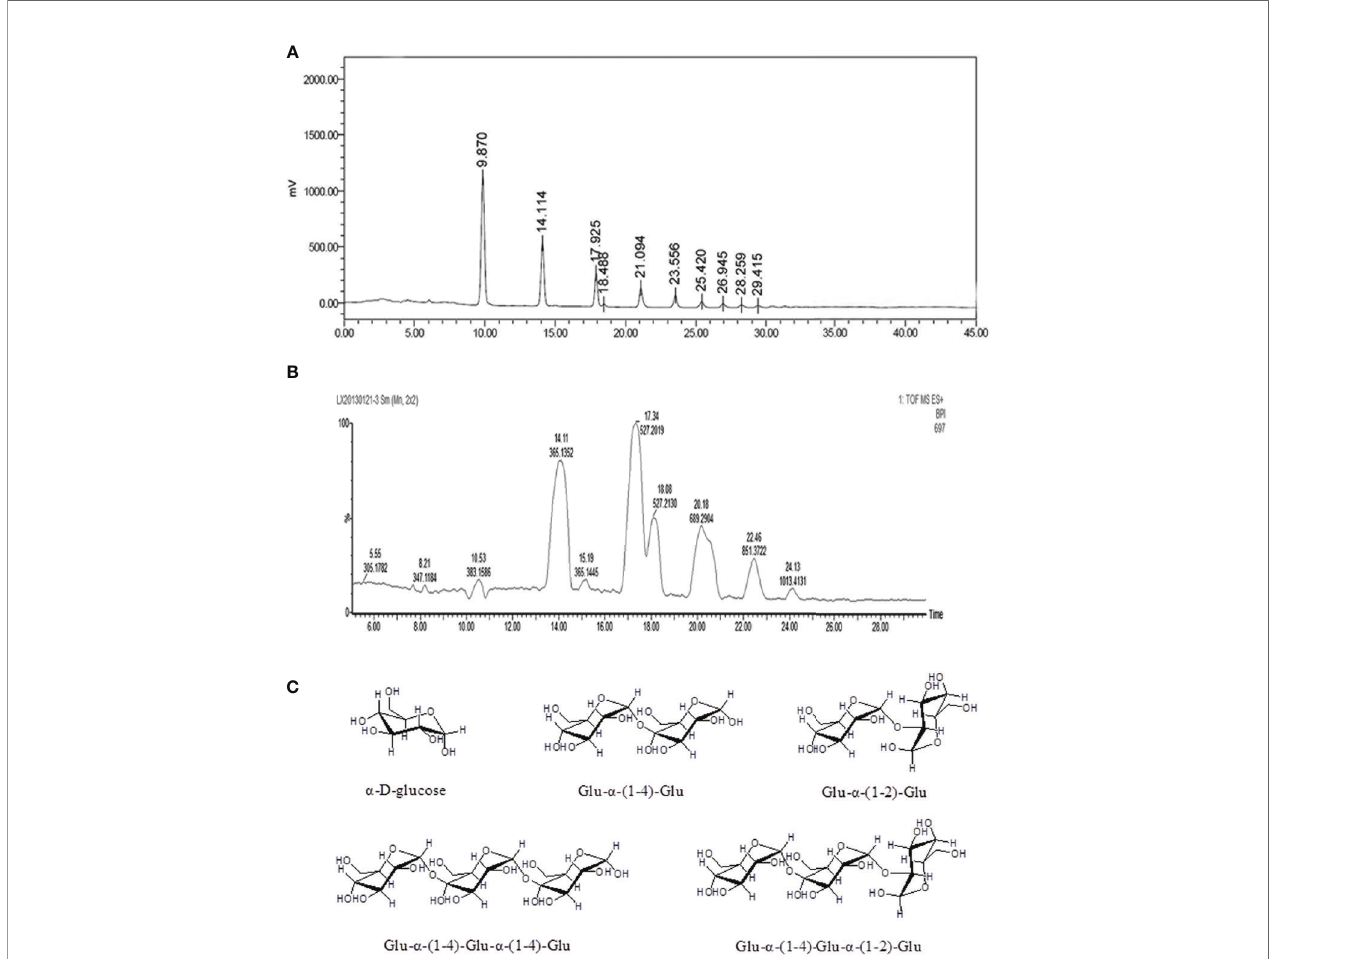
FIGURE 1 | Chemical composition analysis of the Ah-MVPS exhibited by HPLC pro fi le (A) and the total ion fl ow chromatography of LC-QTOF-MS (B) , and structural drawing of representative oligosaccharides detected in the Ah-MVPS product (C)